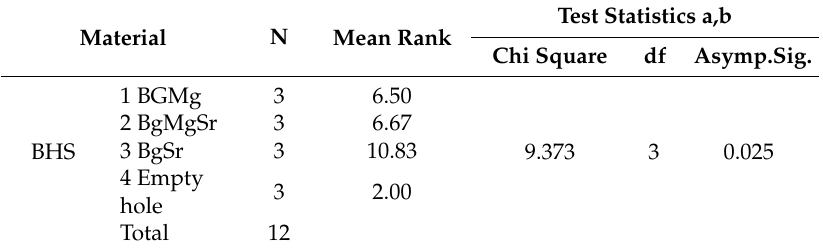
Table 5. Kruskal–Wallis results in terms of bone healing scores (BHS) for BGMg, BGSr, BGMgSr bioactive glasses, and sham hole (empty).